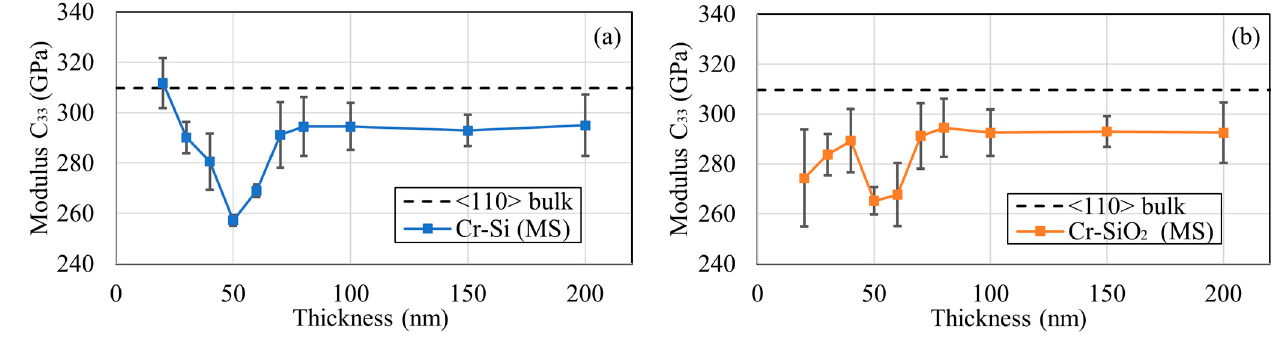
Figure 4. The out-of-plane elastic modulus C 33 of Cr films sputtered on ( a ) the Si substrate and ( b ) the SiO 2 substrate by MS. The broken line denotes the modulus of the monocrystal bulk Cr along the <110> direction.